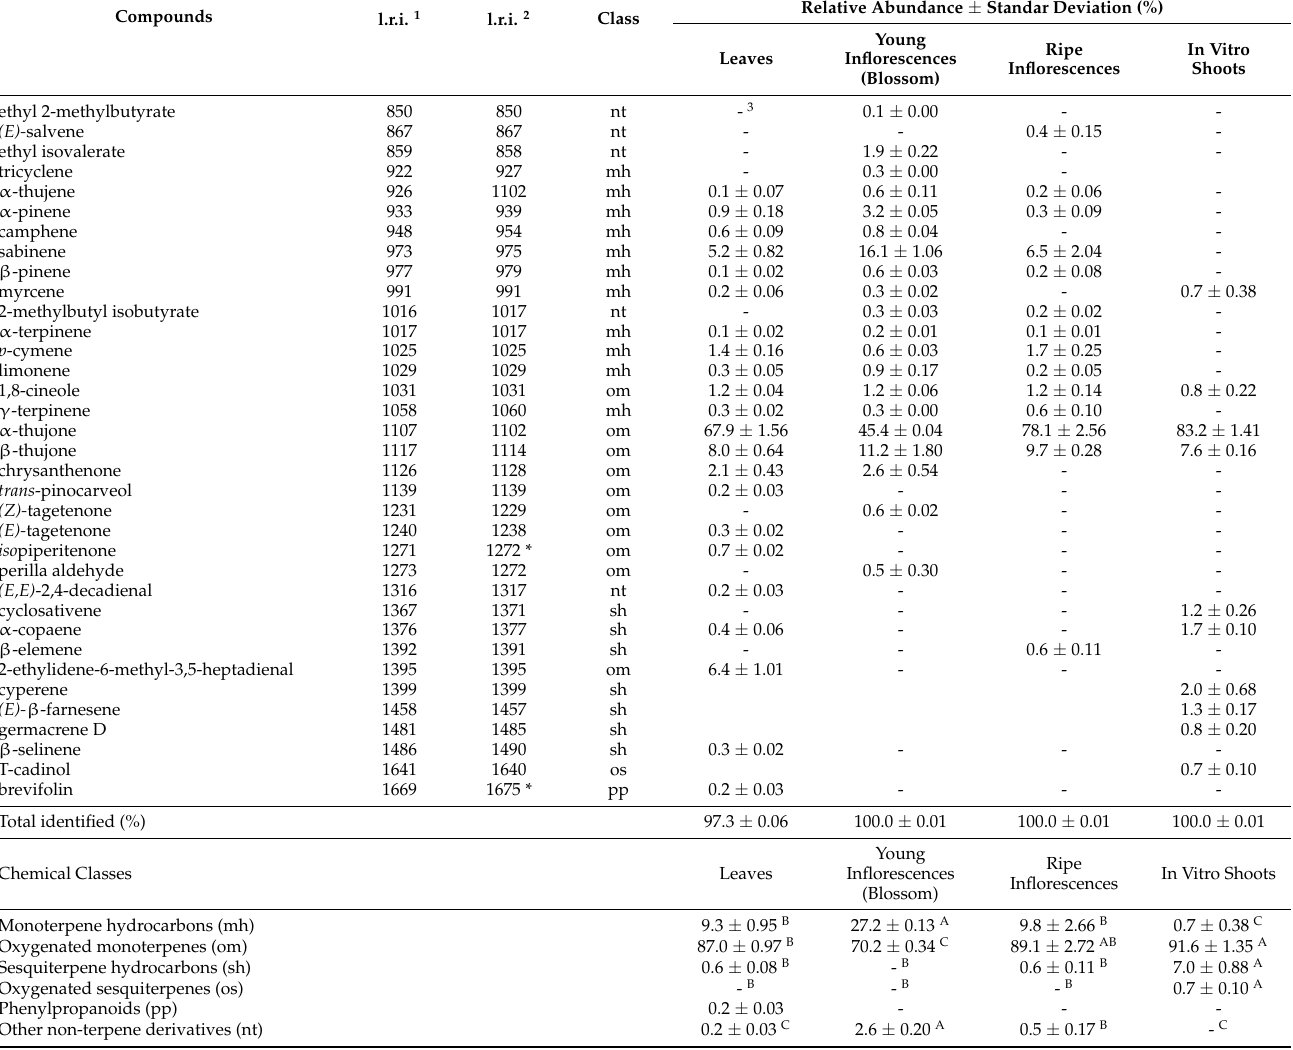
Table 3. Complete chemical composition of the HSs emitted both by different parts of the wild plant (leaves, young inflorescences, and ripe inflorescences) and the 4-week-old in vitro shoots of A. caerulescens ( n = 3. ± SD).